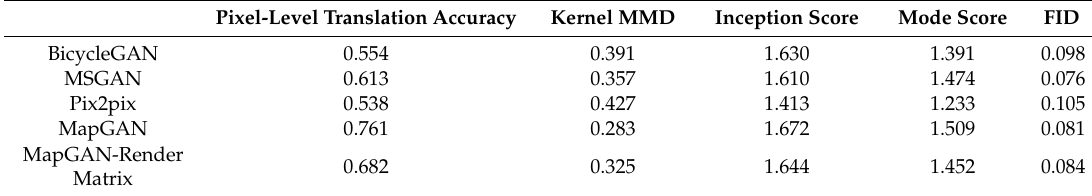
Table 2. Evaluation results of Google Maps generated by MapGAN and some other image translation models in the one-to-one map generation experiment under five different indicators. The first column in the table represents the image translation models used in the test, and the first row represents the indicators used for evaluation.